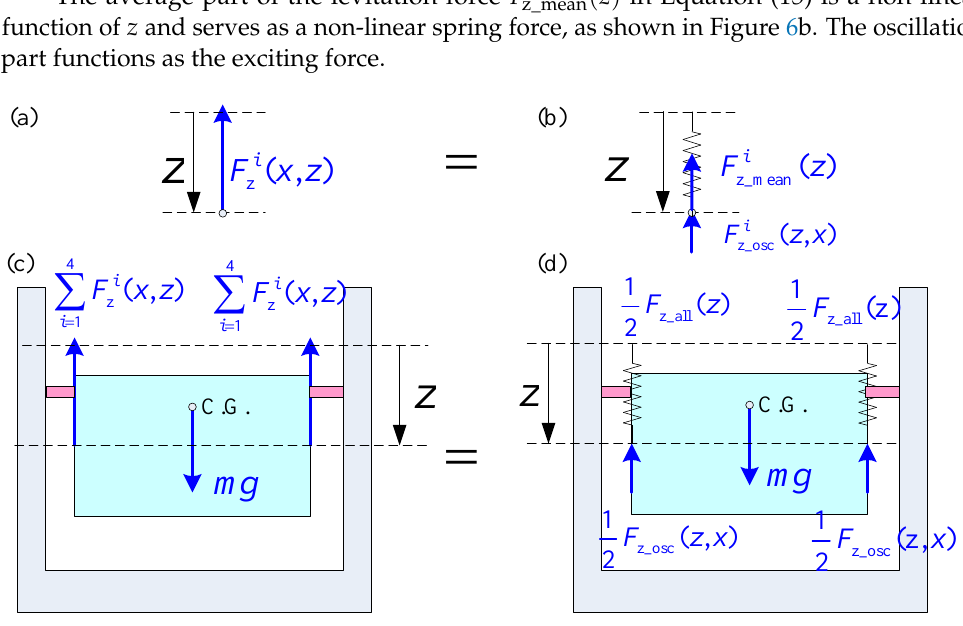
F x z ; ( b ) decomposition of z